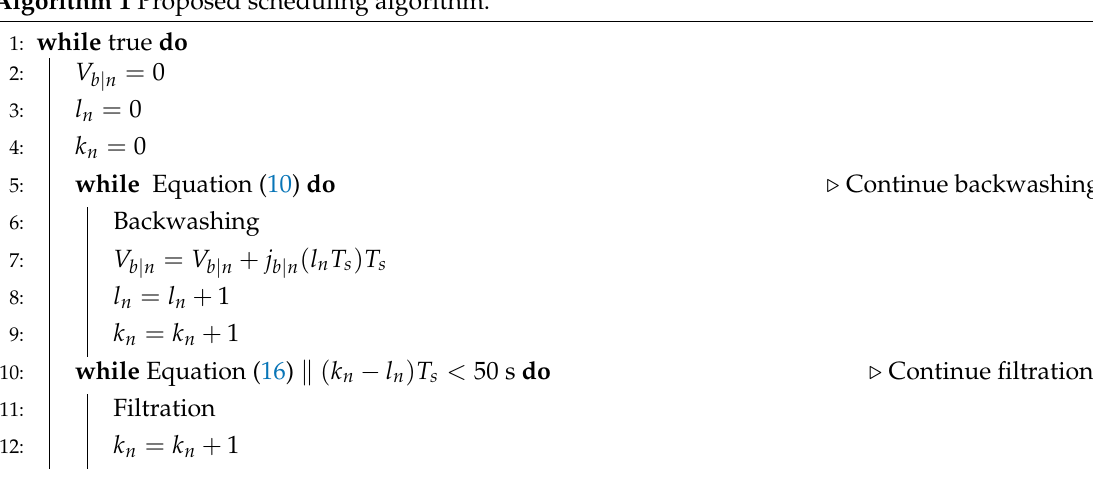
Algorithm 1 Proposed scheduling